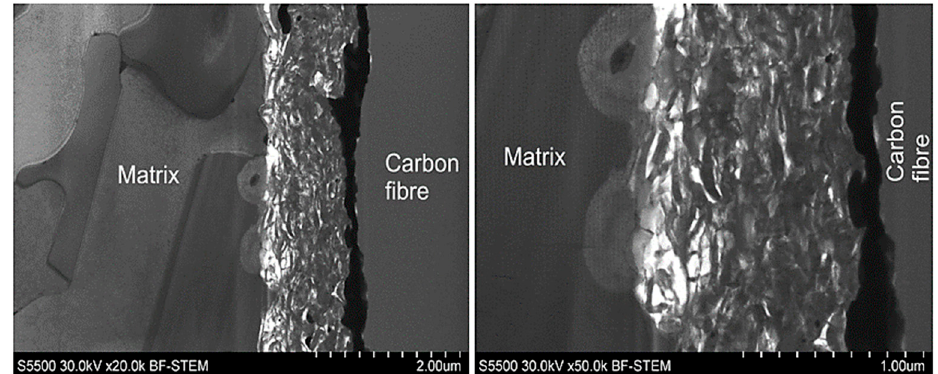
Figure 11. TEM images of the interface between fibre and aluminium alloy matrix of MMC2 sample before the push-out test.